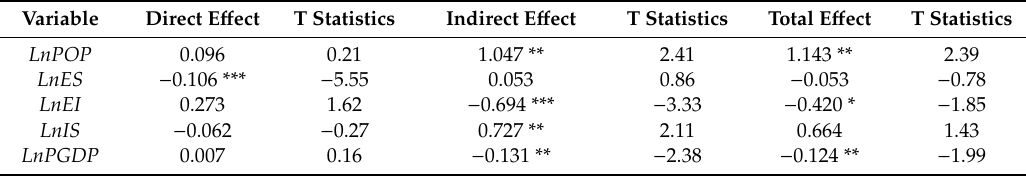
Table 5. Direct, indirect, and total e ff ects for the EGE .